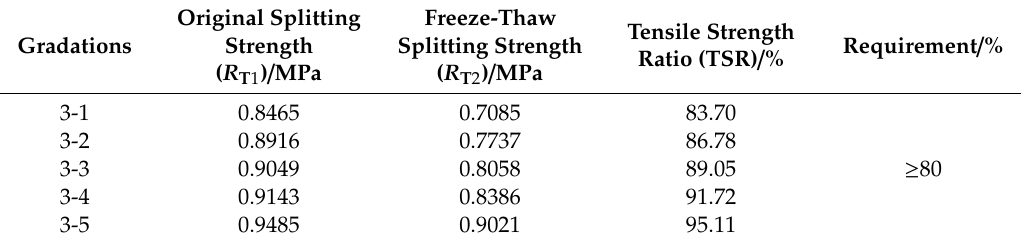
Table 13. Results of the freeze-thaw splitting test.